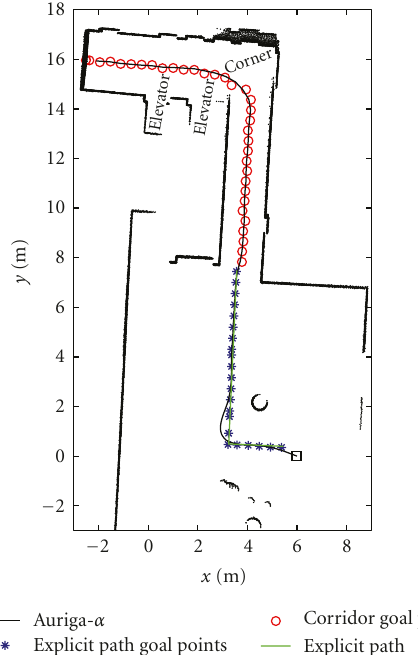
Figure 13: Tracked path along an indoor hall while following an explicit path and a corridor.